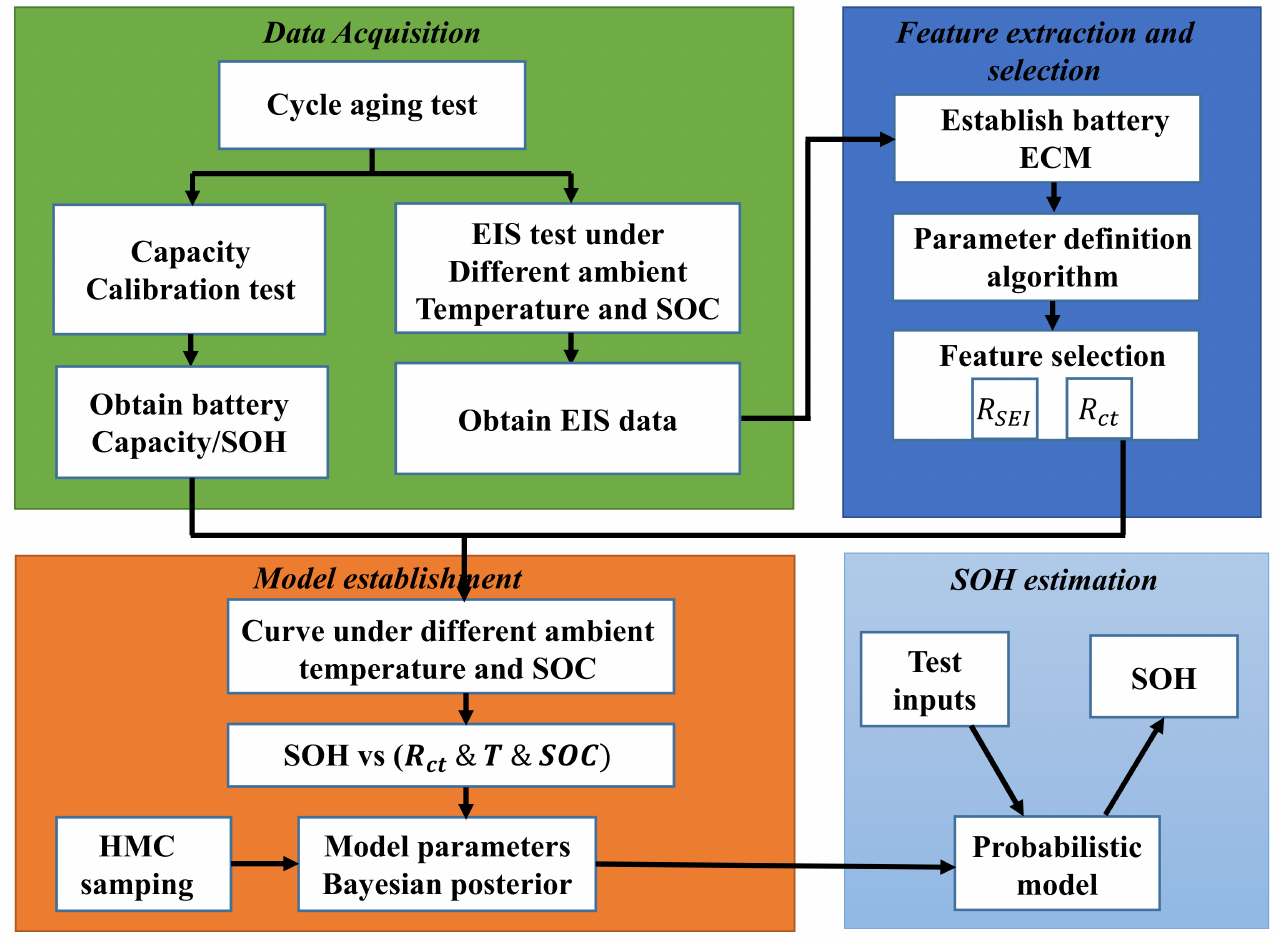
Figure 4. SOH estimation schematics considering SEI resistance. Reprinted with permission from Ref. [53]. Copyright 2022,